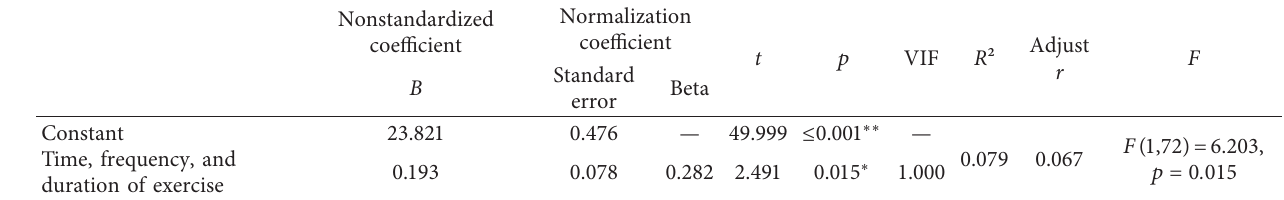
Table 15: Linear regression analysis ( n �